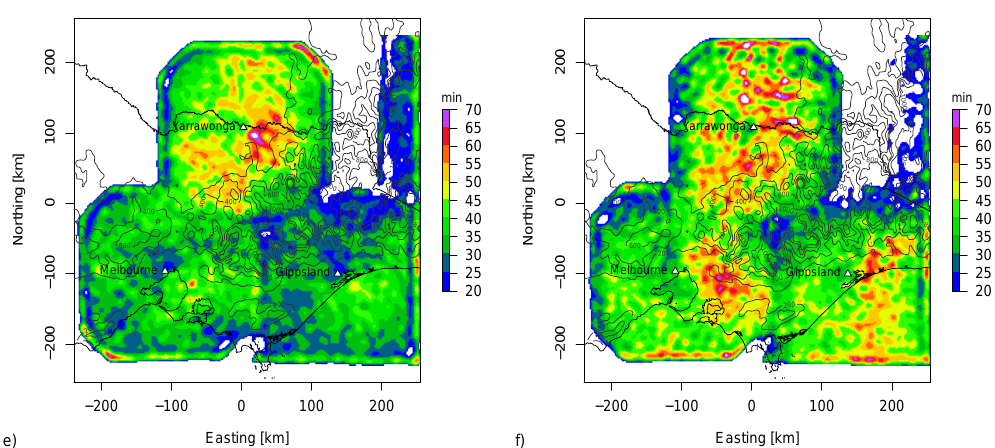
Figure 7. Spatial distribution of the precipitation lifetimes at cascade level 4 (38- 18 -8km) stratified by flow regime. (a) SE, (b) Wm, (c) N, (d) SW, (e) NW, (f)